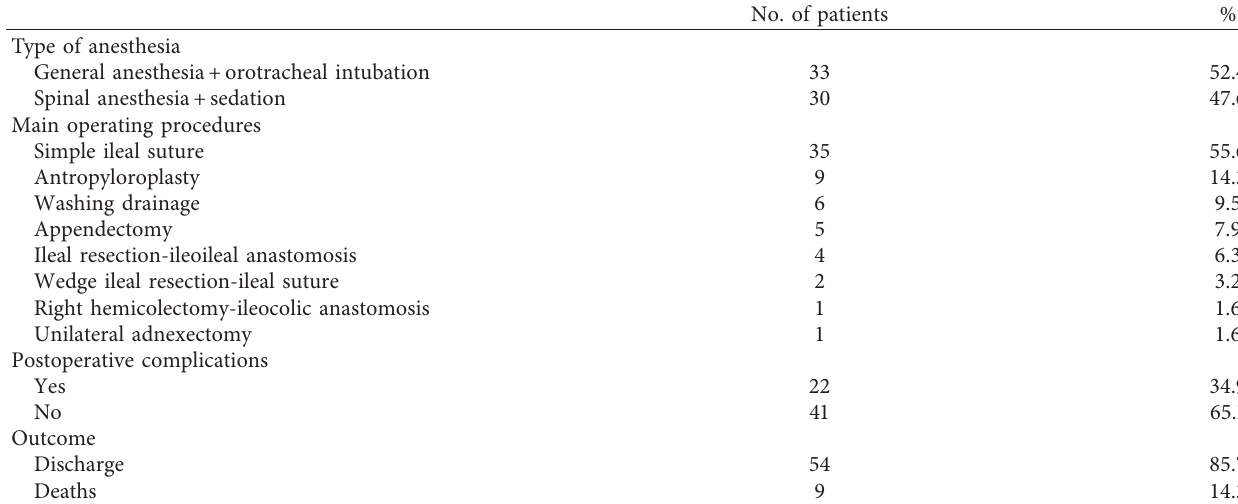
Table 3: Perioperative and postoperative data.